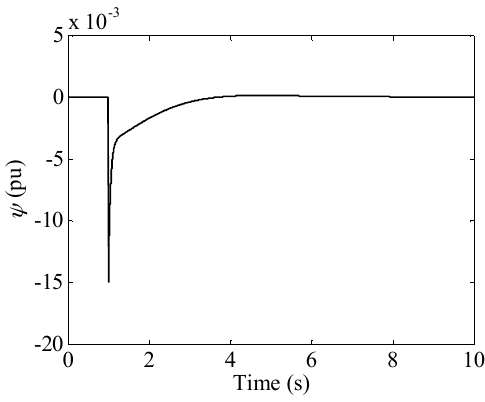
Figure 7. Macro-variable ψ response to a load disturbance.